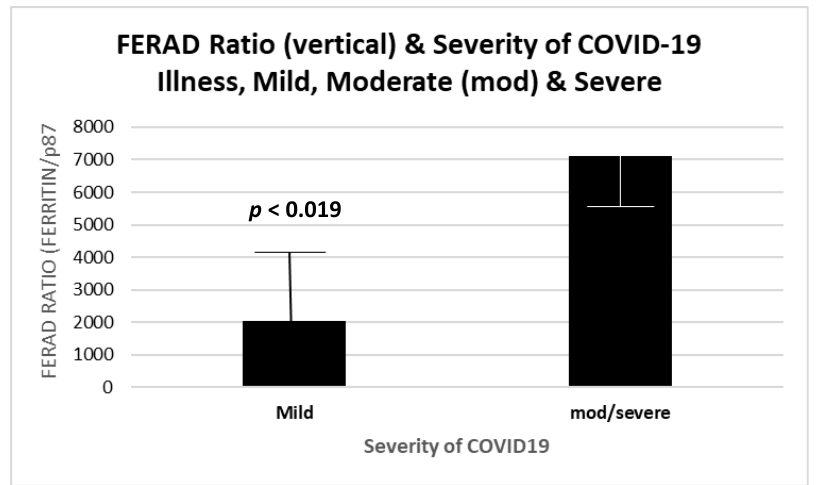
Figure 13. Mean FERAD ratios increased with the severity of COVID-19.